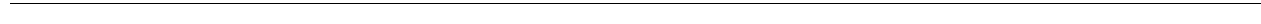
Figure 5 | Adaptive immune response contributes to Axl mediated radiosensitivity. ( a ) The radiation response of Py8119 Axl Cr#1 to 20Gy is decreased in immunodeficient nude mice (RTat 12–14 days, ** P ¼ 0.0036, five mice each). ( b ) There was an increased proportion of infiltrating CD45 þ leukocytes in Axl Cr#1 and pooled tumours and in all tumours 10 days after 20Gy. ( c ) The proportion of CD45 þ CD11b þ F4/80 þ macrophages increased after